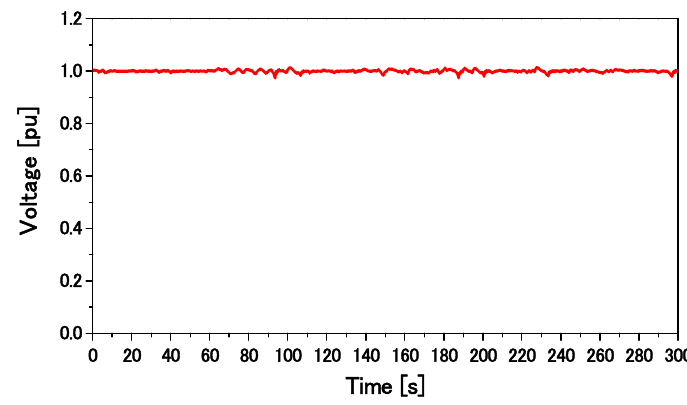
Figure 34. Voltage response at the connection point of wind generators.